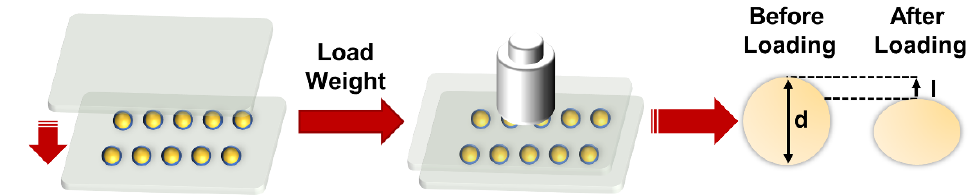
Figure 2. Schematic diagram of compression properties characterization of pellets.